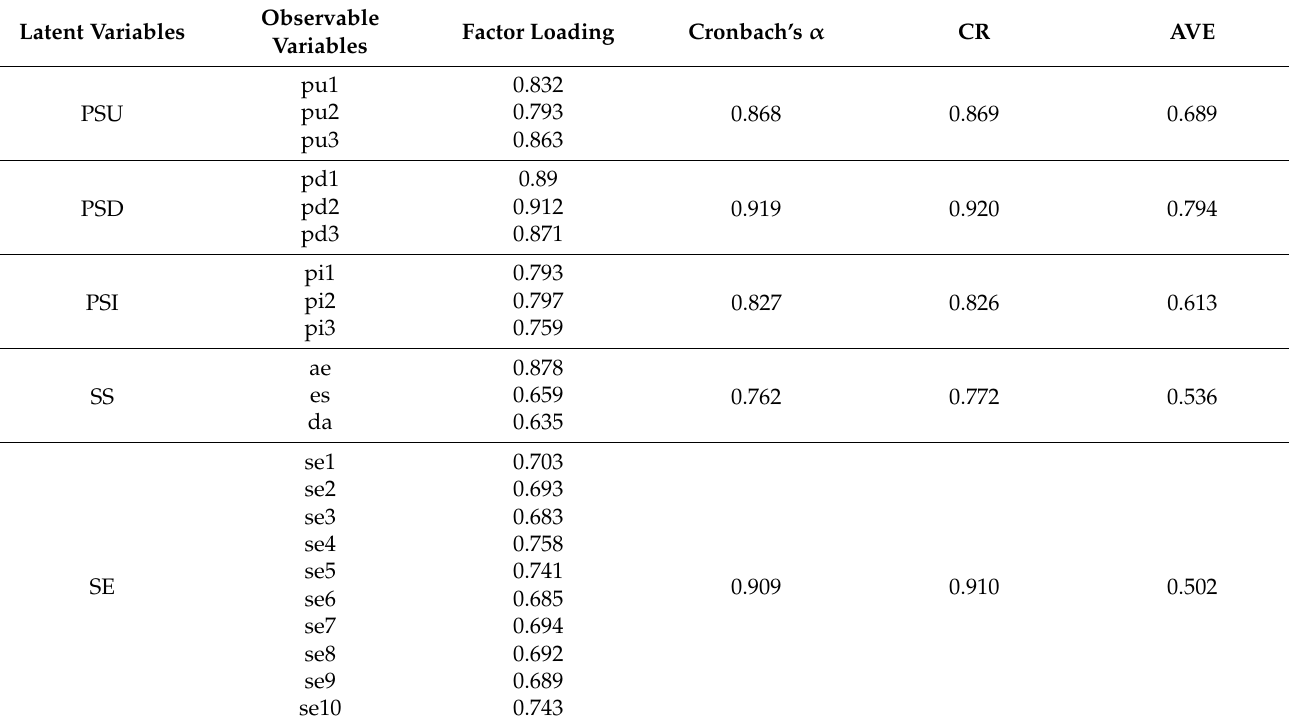
Table 2. Reliability and validity analysis of latent